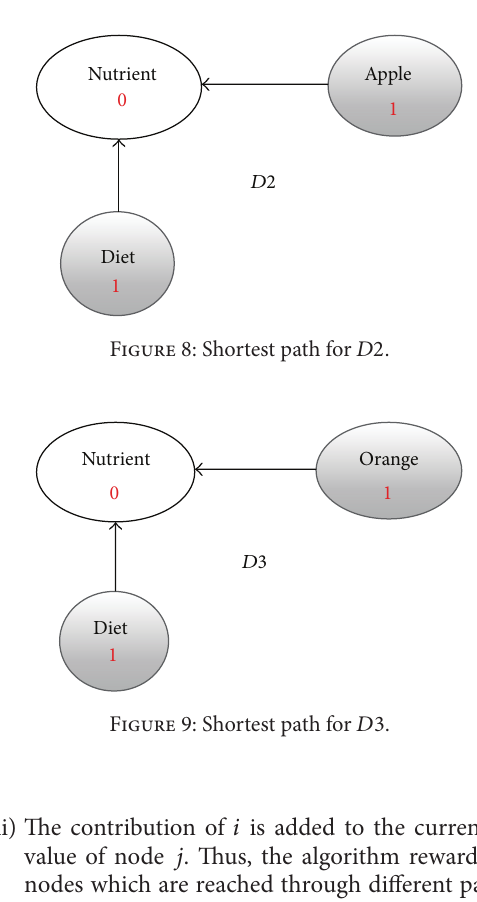
Figure 9: Shortest path for 𝐷3